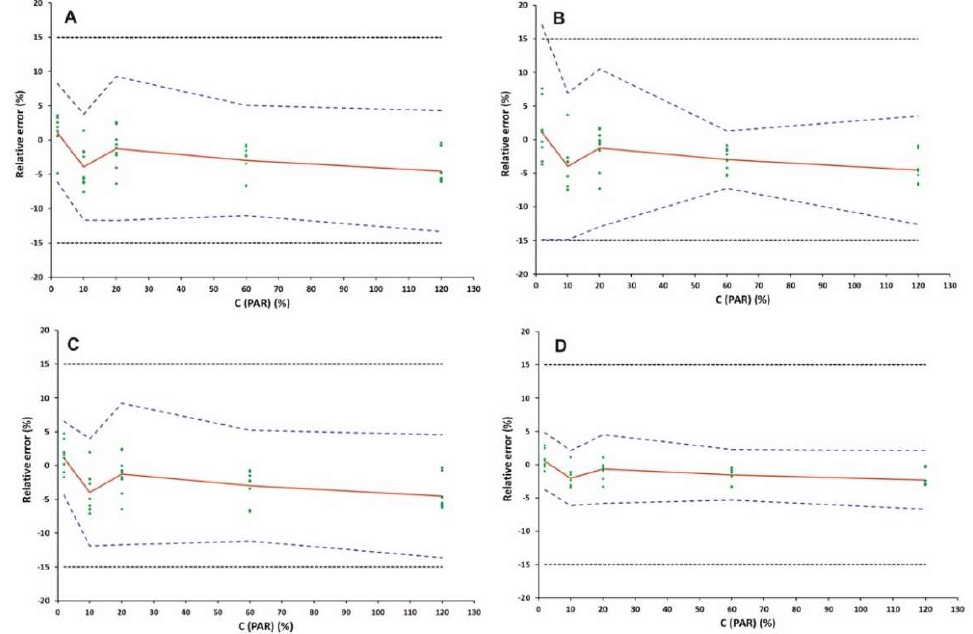
Figure 3. Accuracy profile for the determination of PAR using ( A ) linear unweighted regression model; ( B ) linear regression fitted only at the highest concentration (120% level); ( C ) weighted (1/X) linear regression; ( D ) linear regression after square root transformation. The relative error (%), the accuracy profile and the acceptance limits λ ( ± 15%) are described by the red plain, blue dashed and blank dotted lines, respectively. The dotted curves show the acceptance limits λ ± 15%, the plain blank line shows the Y = X identity line, and the blue dashed line shows the accuracy profile ( β -ETI).